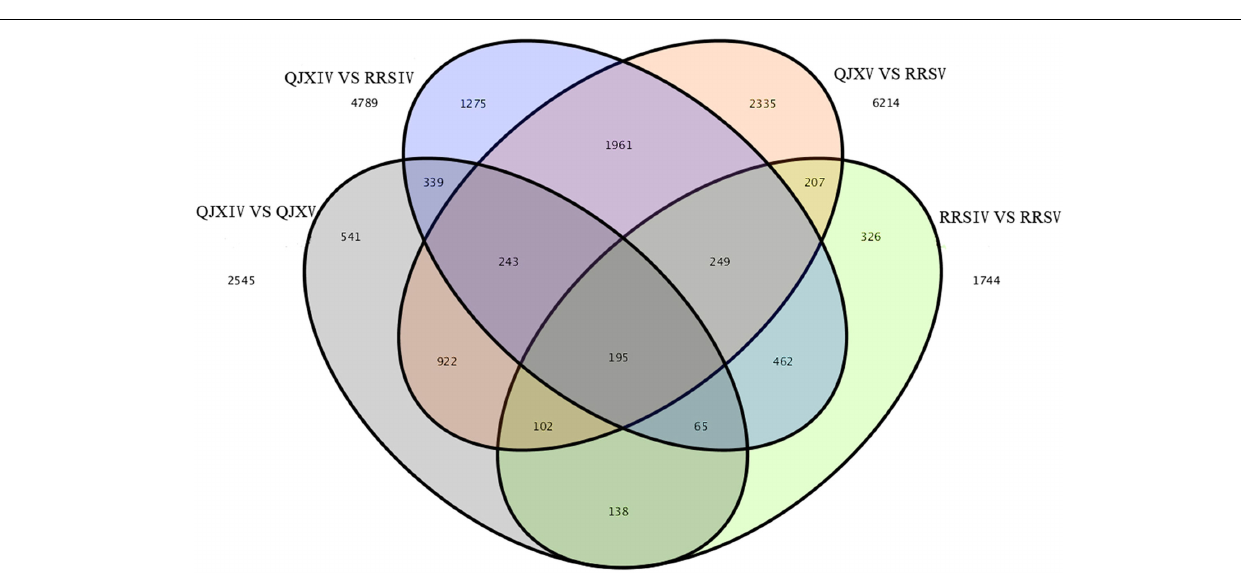
We obtained 46.72 Gb of clean data by RNA-Seq, with 2,182,914 contigs, 199,204 transcripts, and